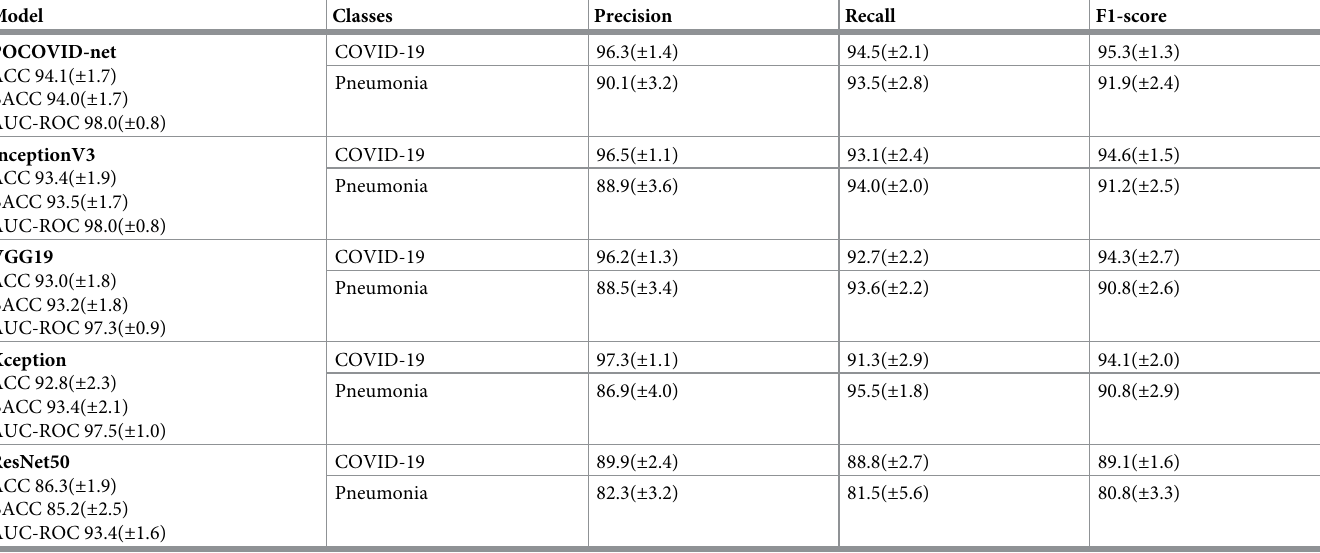
Table 3. Overall COVID-19 vs pneumonia performance results (95%